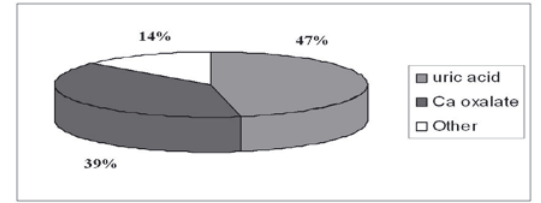
without kidney stones.